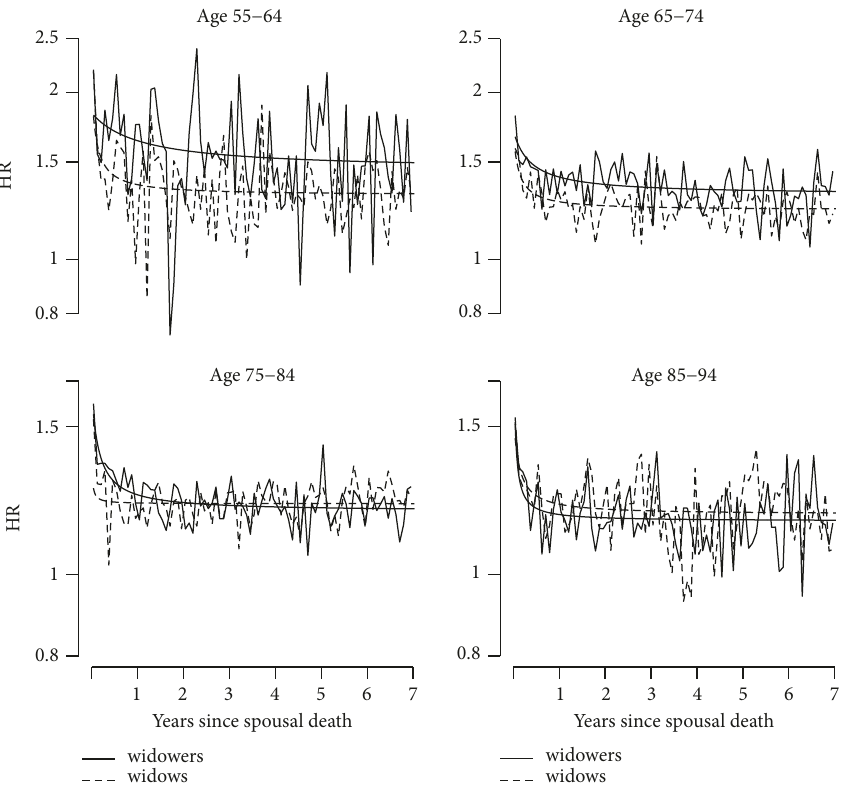
Figure 1: Observed population HR for widowed individuals. Estimated population HR from frailty model (6) (smooth lines).